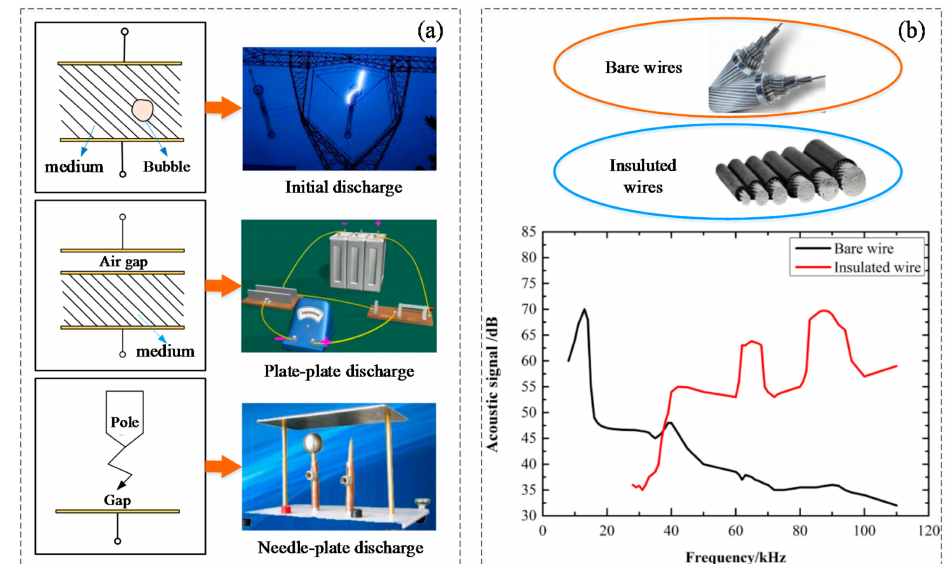
Figure 1. ( a ) The common types of partial discharges (PD); ( b ) bare wire and insulated wire and the discharge spectrum of bare wire and insulated wire in the